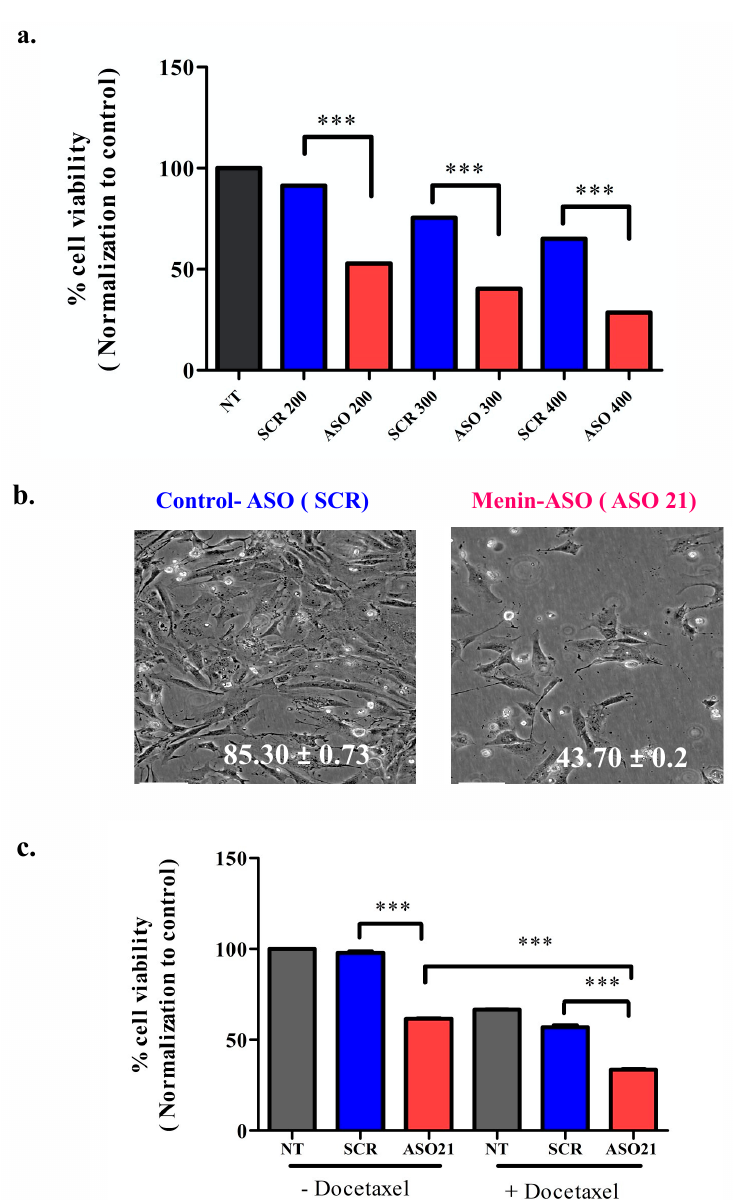
Figure 3. ASO21 reduces Hs 578T viability and enhances chemosensitivity of TNBC. ( a ) ASO21 decreases Hs 578 cellular viability in dose dependent manner. Hs 578T cells were treated with ASO21 and scrambled-ASO (SCR) at various concentrations (200 nM, 300 nM, 400 nM). Three days after the second transfection, cell proliferation was assayed by alamar blue. ( b ). Representative images of Hs 578T cells that were treated with control-ASO or menin-ASO (ASO21). ( c ) ASO21 enhances chemosensitivity of Hs 578T cell to Docetaxel. After the second ASO transfection at 200 nM 2 days, Docetaxel 100 nM was added and incubated for 2 days before the MTT tests. Menin knockdown using ASO 21 increased cellular sensitivity to Docetaxel since cell survival decreased significantly with combination of this chemodrug with menin-ASO compared with monotherapy using menin-ASO alone was considered significant, with *** p ≤